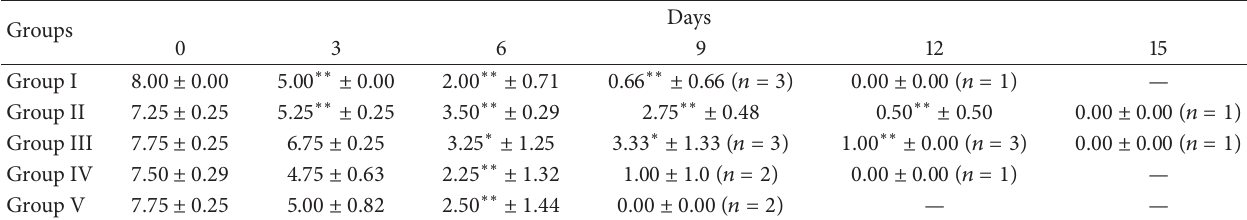
Table 2: GUE indices of dogs of different groups at various observation intervals (mean ± S.E.).